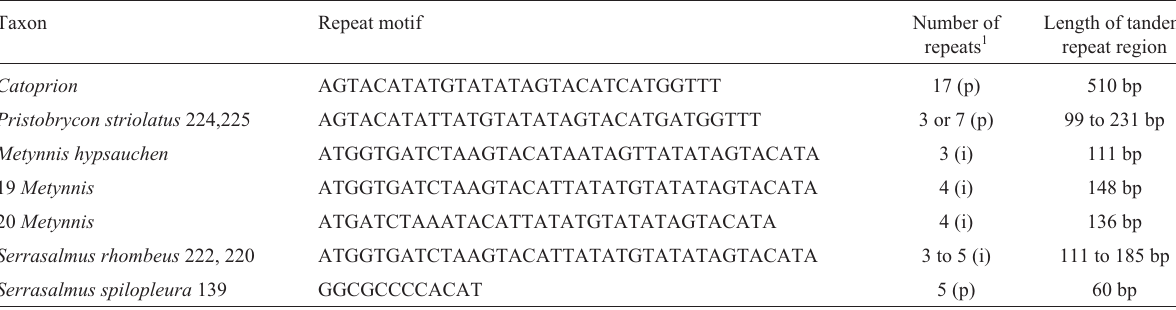
Table 1 - Tandem repeats in the 3’ region of the Control Region of serrasalmid taxa. Taxon